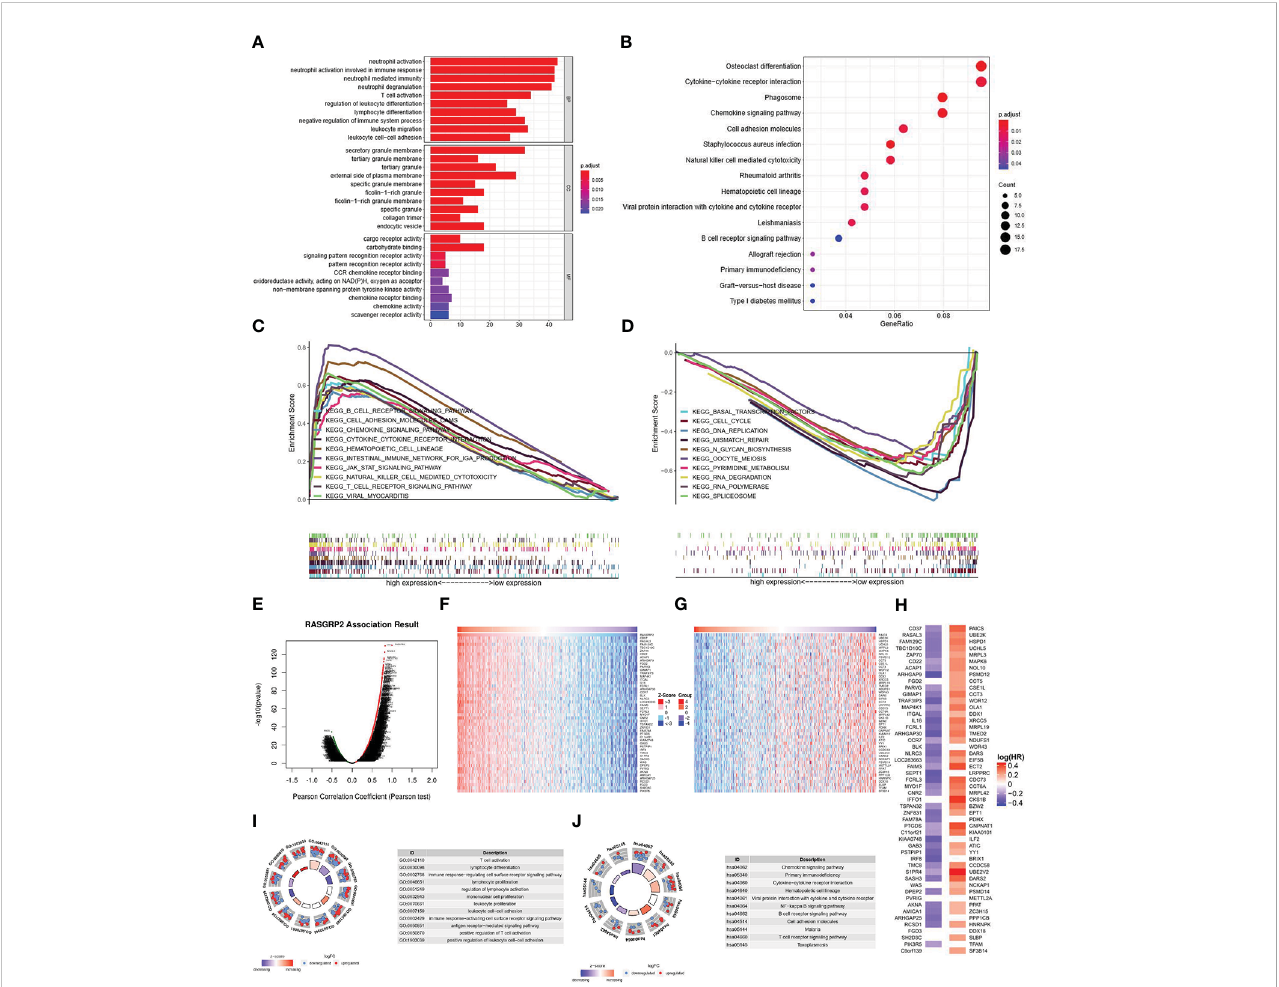
FIGURE 7 The potential mechanisms of RASGRP2 in LUAD. (A, B) GO and KEGG analysis of 397 blue module genes. (C, D) GSEA showed the enriched pathways in the high and low RASGRP2 groups. (E) The volcano plot showed the whole related genes to RASGRP2. (F, G) Top 50 RASGRP2-related genes with positive/negative correlation. (H) Survival map of the top 50 genes positively/negatively associated with RASGRP2 in LUAD. (I) GO annotations of RASGRP2 in LUAD cohort. (J) KEGG analysis of RASGRP2 in LUAD